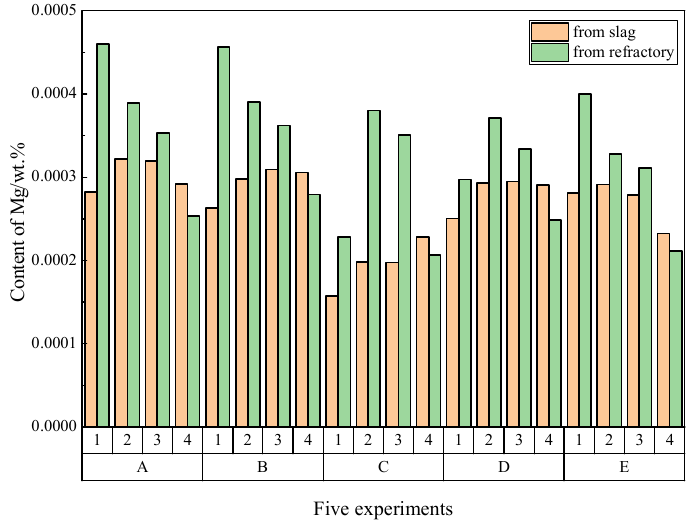
Figure 6. The content of magnesium provided by slag and refractory to molten steel at 1600 °C .